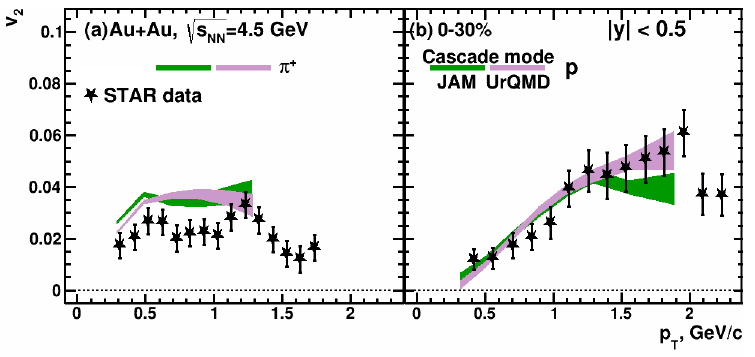
Figure 3. Transverse momentum ( p T ) dependence of elliptic flow v 2 of pions ( a ) and protons ( b ) √ s NN = 4.5 GeV. The black closed symbols denote the in the 0–30% central Au + Au collisions at published data from the STAR experiment [16]. The purple and green bands represent the results from the cascade mode of UrQMD and JAM models, respectively. The uncertainties of the simulated model data are